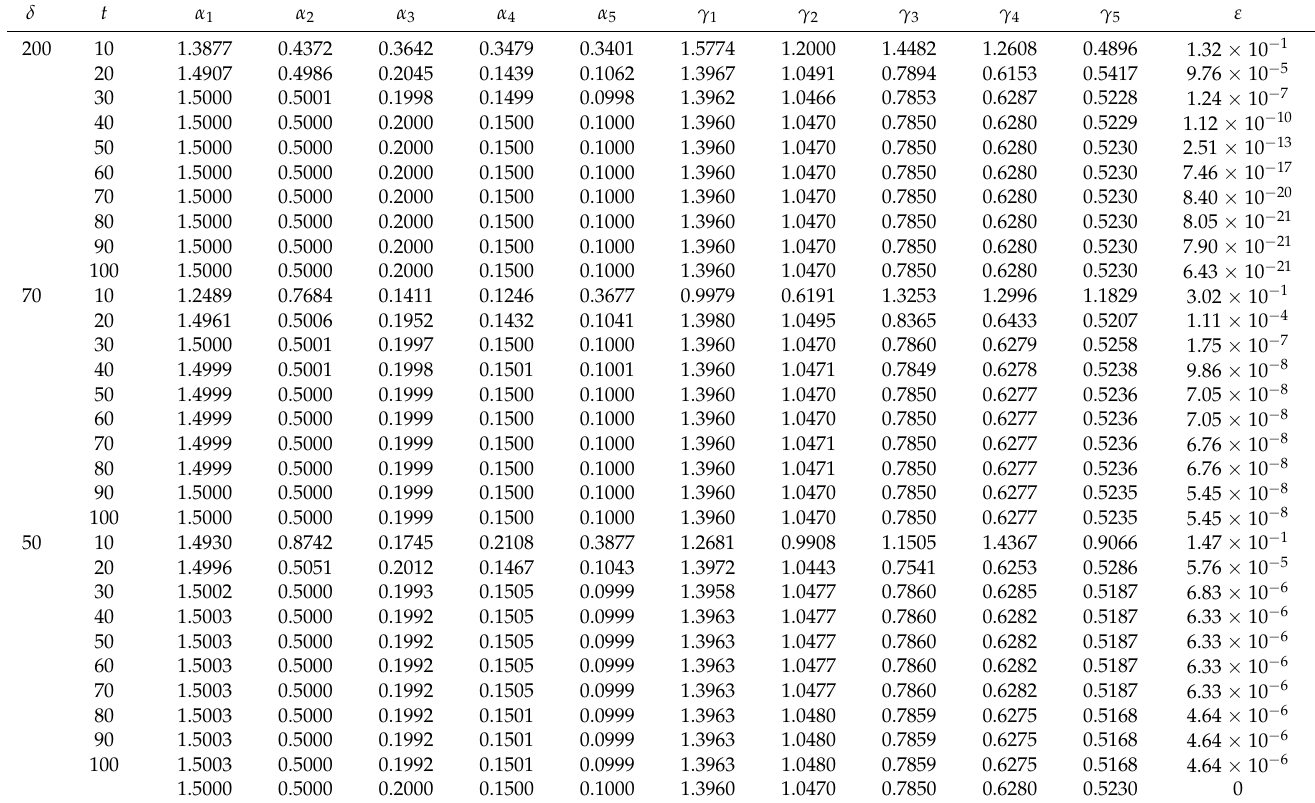
Figure 4. Cost function iterative adaptation for different noise scenarios. ( a ) 200 dB ( b ) 70 dB ( c ) 50 dB. Table 1. Fitness results along with the estimated values for λ = 0.1.